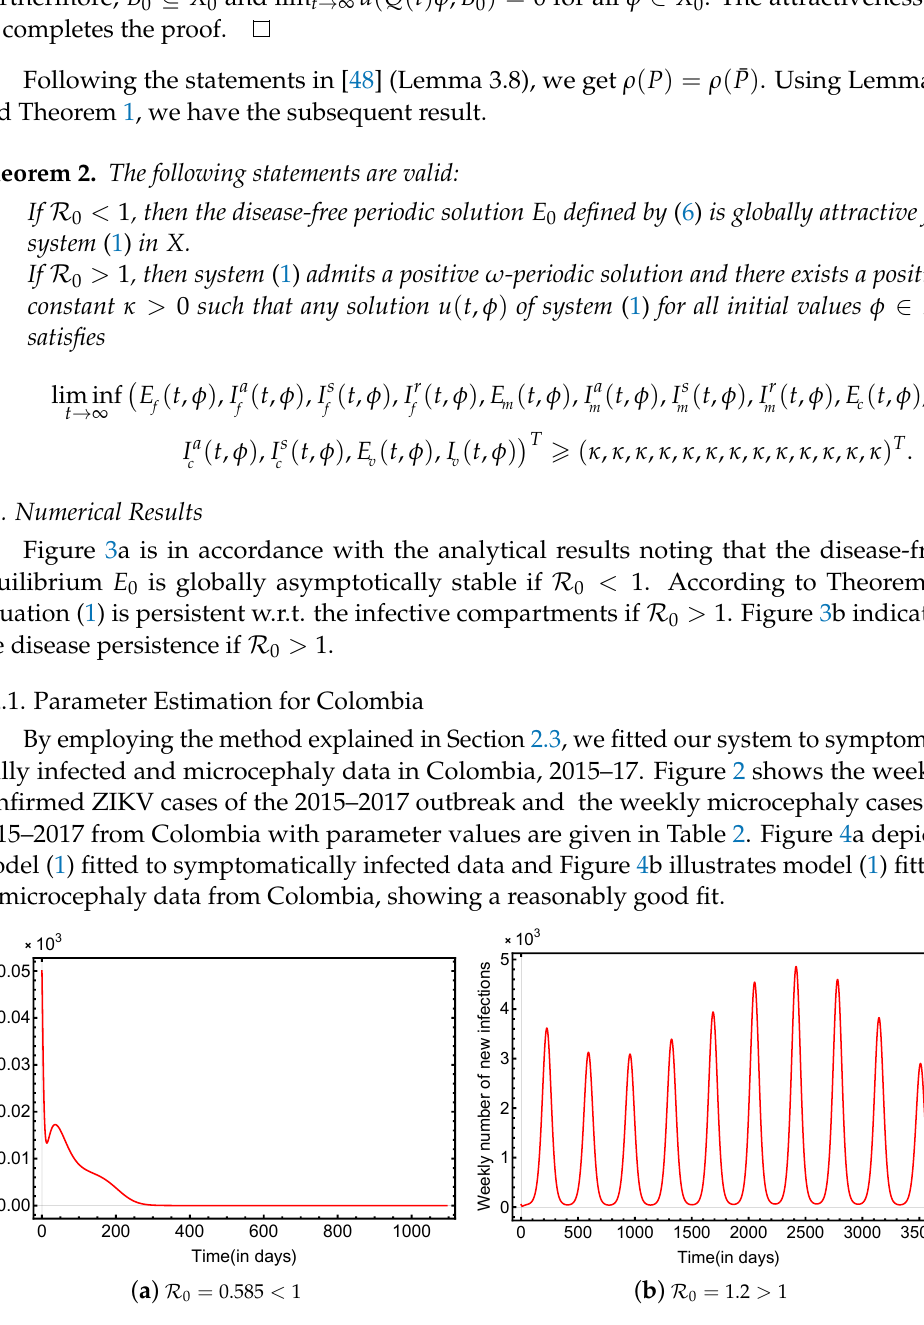
Figure 3. Weekly number of Zika new infections in ( a ) when R 0 = 0.585 < 1, α h = 0.112, α v = 1.2 and B v = 41,400, and in ( b ) when R 0 = 1.2 > 1, α h = 0.185, α v = 0.139 and B v = 95,000. The rest of the parameter values are given in Table